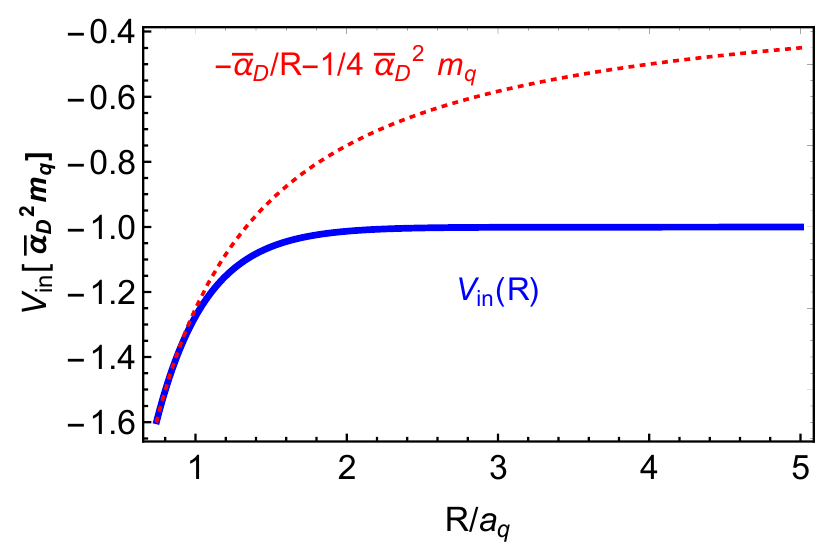
Figure 2. The incoming e(cid:11)ective potential V in in units of (cid:22) (cid:11) 2 Born-Oppenheimer approximation (blue solid), as a function of X { (cid:22) X separation in units of the Bohr radius a q = 1 = ((cid:22) (cid:11) D m q ). Also shown is the Coulomb potential for the ( X (cid:22) X ) quarkonium (red